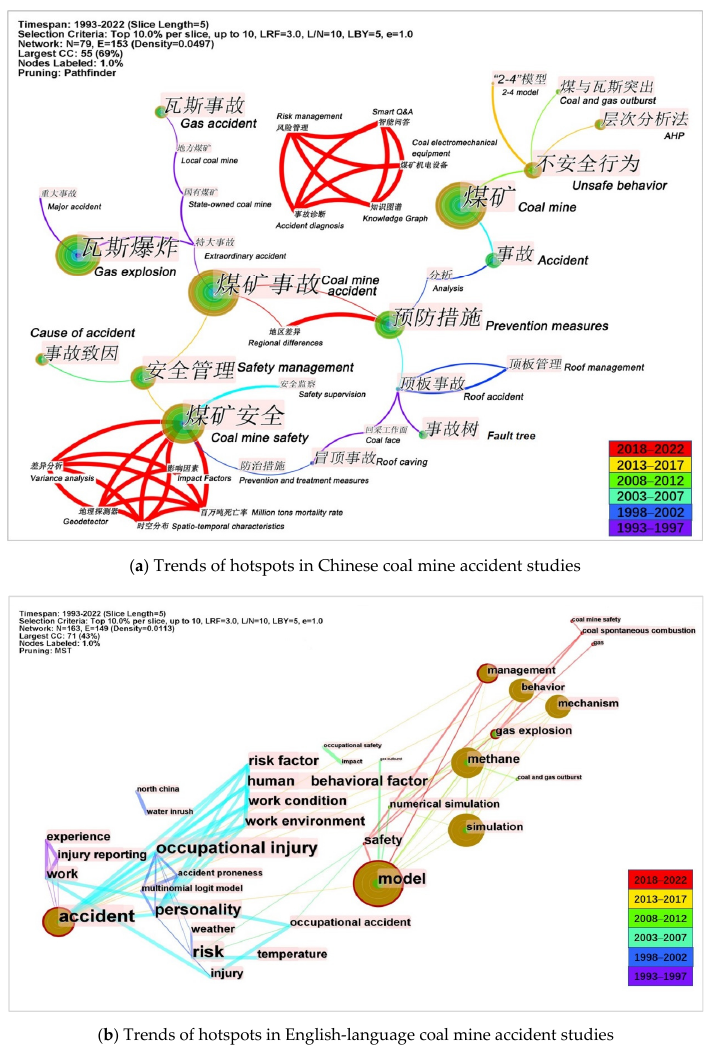
Figure 11. Trends of hotspots in Chinese and English coal mine accident